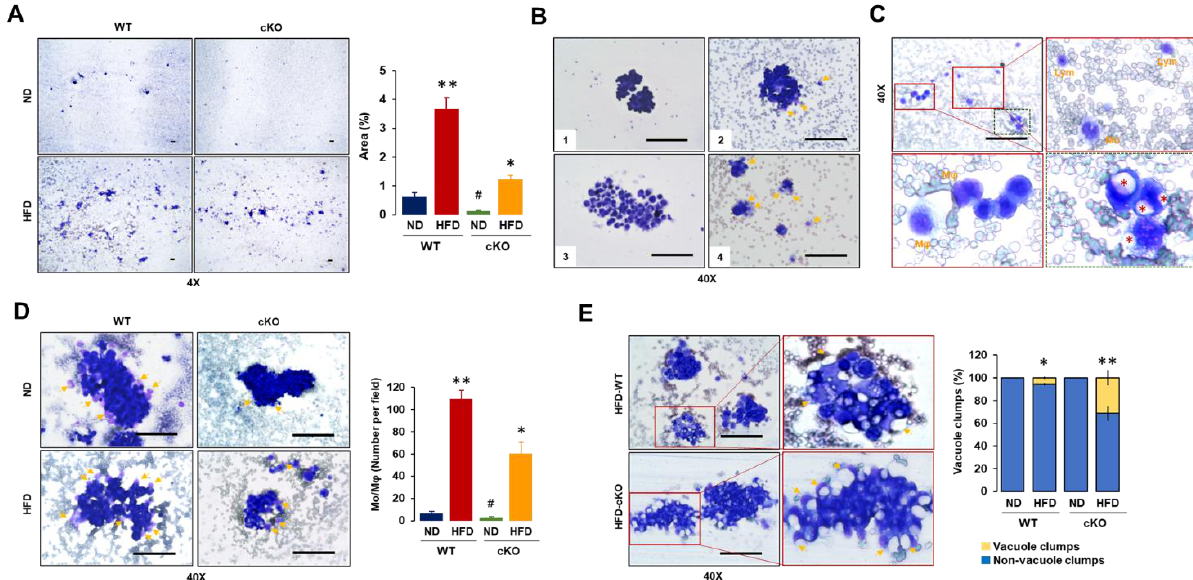
Figure 3. Cellular characteristics of OC-induced ascites in a postmenopausal, diet-induced, obese mouse model between CXCR2 WT and cKO mice. ( A ) Comparison of floating cells in OC-induced ascites obtained from lean and obese CXCR2 WT and cKO mice bearing mouse ID8 OC cells. Area measurement was calculated from 5 random fields of each slide with ImageJ. ( B ) Morphological patterns of floating tumor cells in OC-induced ascites. B1: intact floating tumor cells; B2: Mo/M ϕ -attached floating tumor cells; B3: dispersed floating tumor cells with immune cells; B4: small clumps of floating tumor cells attached with monocyte/M ϕ . Yellow arrows indicate Mo/M ϕ . ( C ) Morphological patterns between immune and tumor cells in OC-induced ascites. Lym: lymphocytes. Red asterisks: signet ring-like cells containing cytoplasmic vacuoles. ( D ) Numerical comparison of Mo and M ϕ in OC-induced ascites from ND-WT, ND-cKO, HFD-WT, and HFD-cKO mice. Yellow arrows indicate attached Mo and M ϕ . Cell number was obtained from 5 random fields of each slide under microscope. ( E ) Comparison of vacuole and non-vacuole clumps in OC-induced ascites; clump number was obtained from 10 random fields of each slide under microscope. Yellow arrows indicate vacuoles. *, **, and # indicates significant difference ( p ≤ 0.05) between groups as analyzed by ANOVA and Tukey’s pairwise comparison tests.